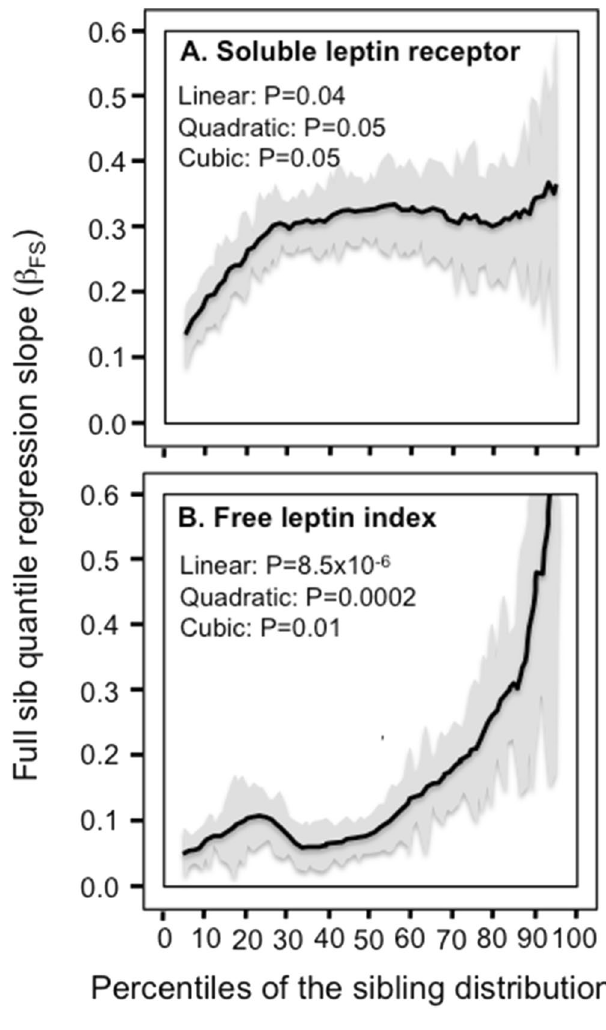
Figure 3. Quantile-specific full sib regression slopes (β FS ) by quantiles of the: A) soluble leptin receptor distribution; B) free leptin index (FLI, i.e., the ratio of leptin to soluble leptin receptor